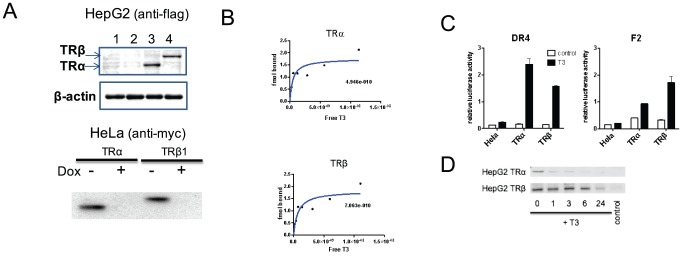
Cells that express TRs.
A. Equal expression of exogenously expressed TRs. Upper panel, western blot of extracts of HepG2 parental cells (1), HepG2 cells infected with control lentivirus (2) or cells infected with lentivirus expressing TRα (3) or TRβ (4) and blotted with anti-flag antibody. Inset beneath shows the same extracts blotted with a β-actin antibody as a loading control. Lower panel; western blot of HeLa-TR extracts after +/− doxycycline withdrawal to induce TRs and blotted with anti-myc. B. Results of T3 binding assays performed on extracts of HeLa-TR cells after 24 hrs doxycycline withdrawal; figures in panels represent deduced affinities of expressed TRs for T3. C. Results of luciferase assays performed upon HeLa-TR cells transfected with standard TRE-driven reporters, DR-4 Luc and IP-6 (F2)-Luc after doxyclycline withdrawal to induce TR expression. D. Western blot of HepG2-TR extracts at various times after initial T3 treatment.